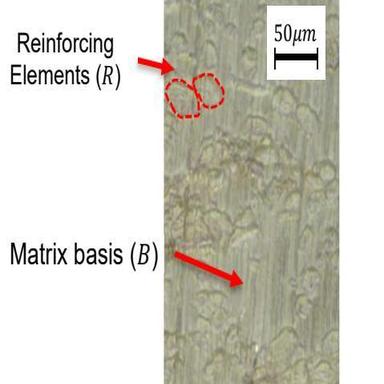
n optical microscopic image. The scale is shown in the figure, and the following figures 2, 3, and 4 are the same.